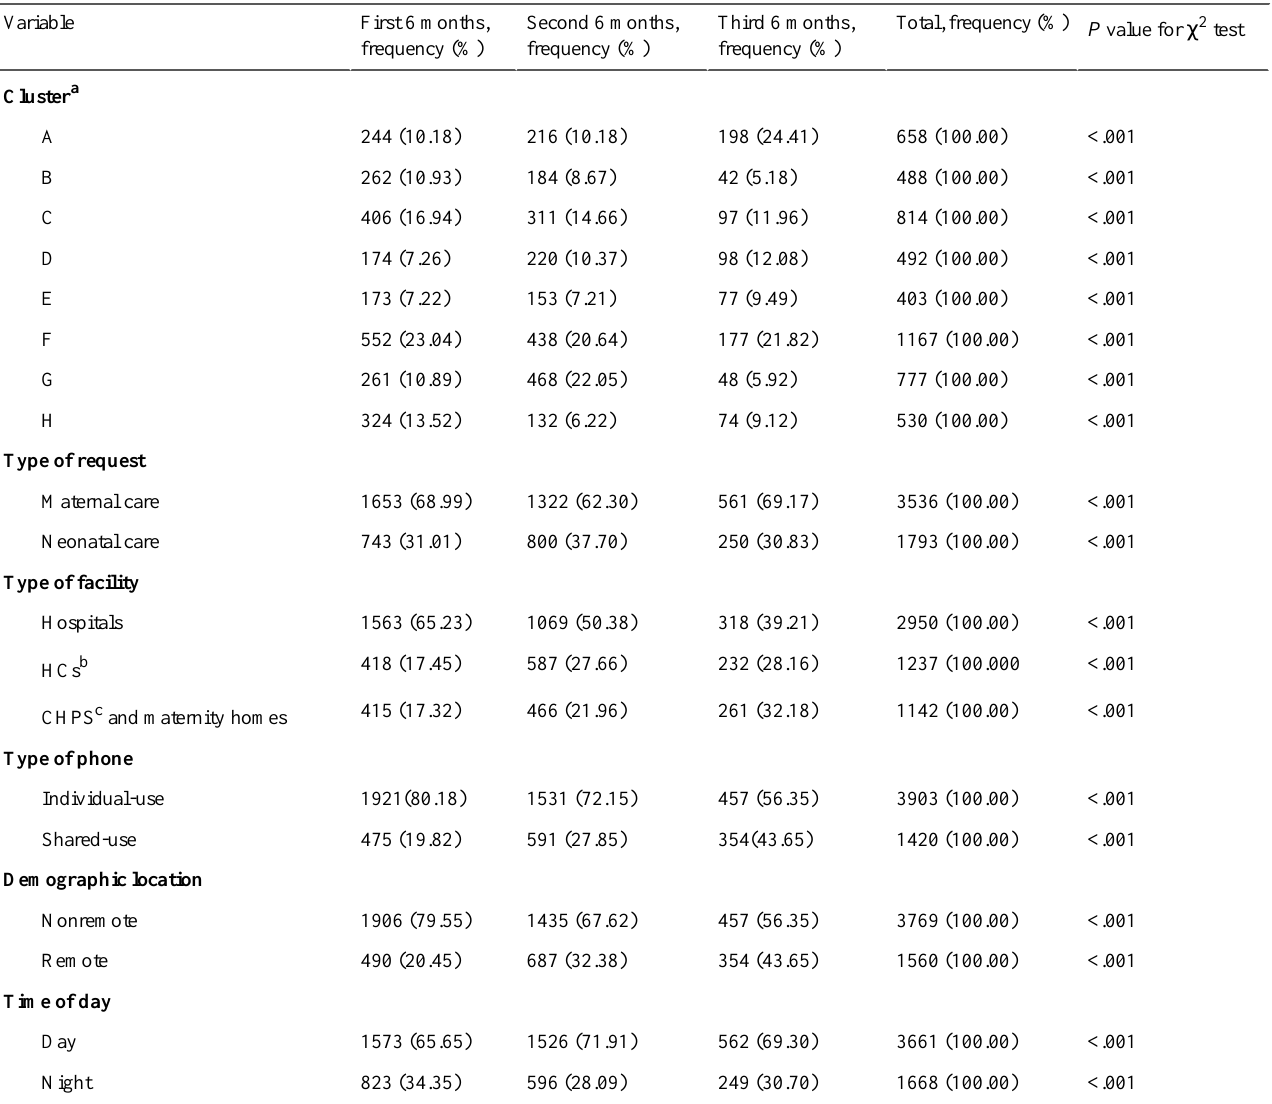
Table 2. Distribution of unstructured supplementary service data requests at 6-monthly